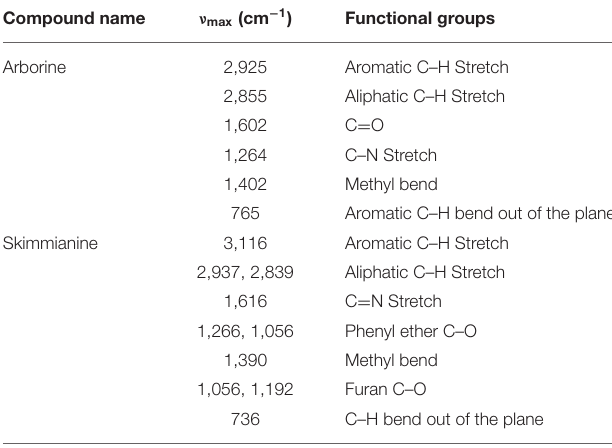
TABLE 1 | FT-IR spectrum of arborine and skimmianine